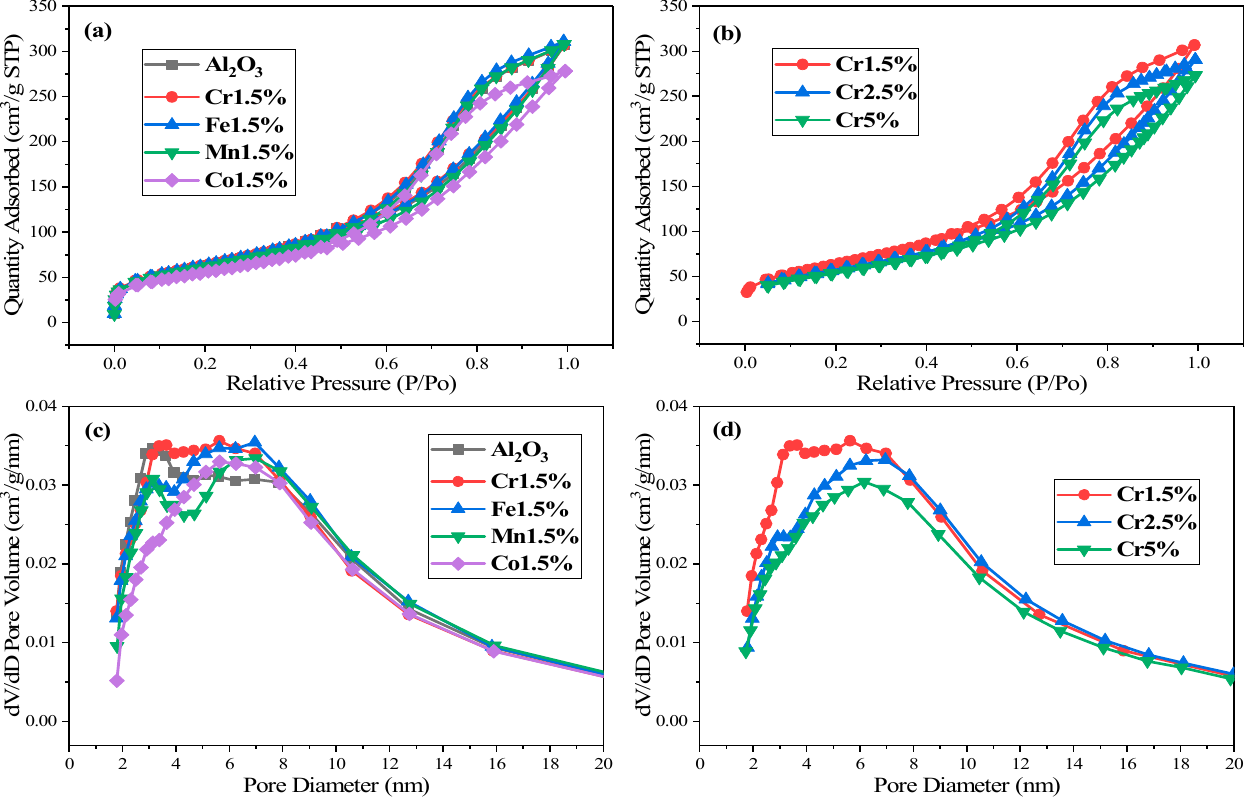
Figure 3. The N 2 adsorption/desorption isotherms of different catalysts. ( a ) γ -Al 2 O 3 , MO x / γ -Al 2 O 3 (M = Cr/Fe/Mn/Co); ( b ) Cr1.5~5%; and pore size distribution curves of ( c ) γ -Al 2 O 3 , MO x / γ -Al 2 O 3 (M = Cr/Fe/Mn/Co); ( d ) Cr1.5~5%. Table 4. Textural properties of MO x / γ -Al 2 O 3 (M = Cr/Fe/Mn/Co) catalysts. Catalysts Surface Area a (m 2